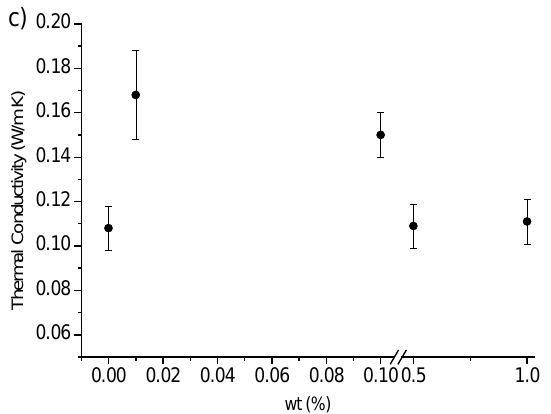
Figure 10. Thermal conductivity of UV-LED cured EB150 and its composite films as a function of filler loading: ( a ) with MWCNTs, ( b ) with biochar and ( c ) with biochar/MWCNTs. Different trends can be observed, according to the filler type and loading.